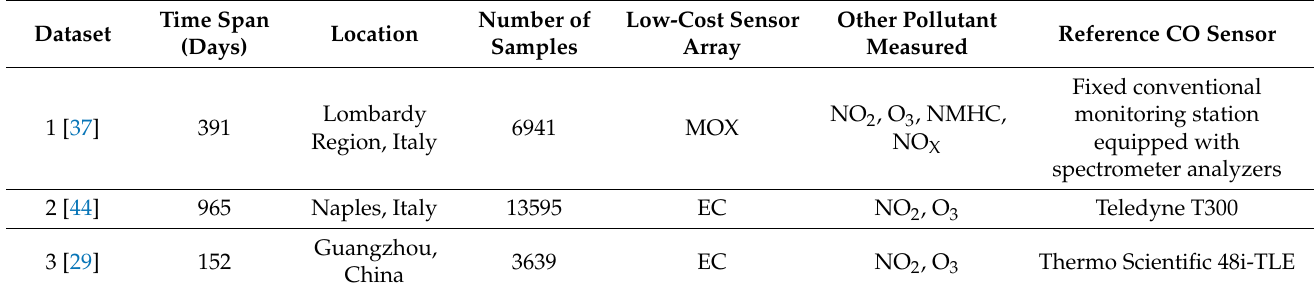
Table 2. Details of the three datasets used in this